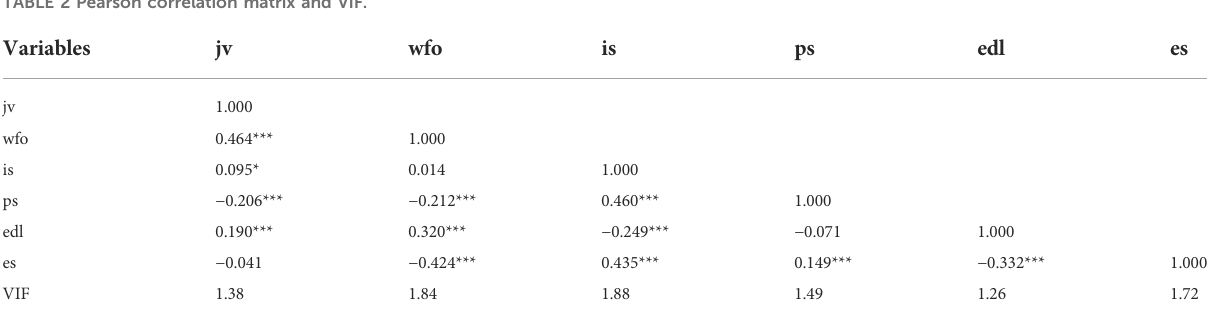
TABLE 2 Pearson correlation matrix and VIF.